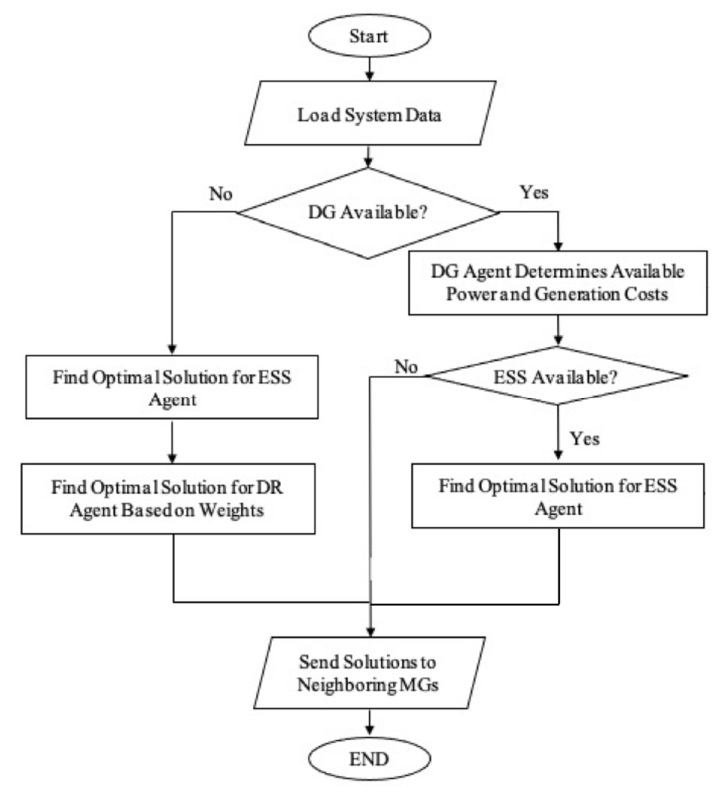
Figure 6. Agent-based microgrid power management process .